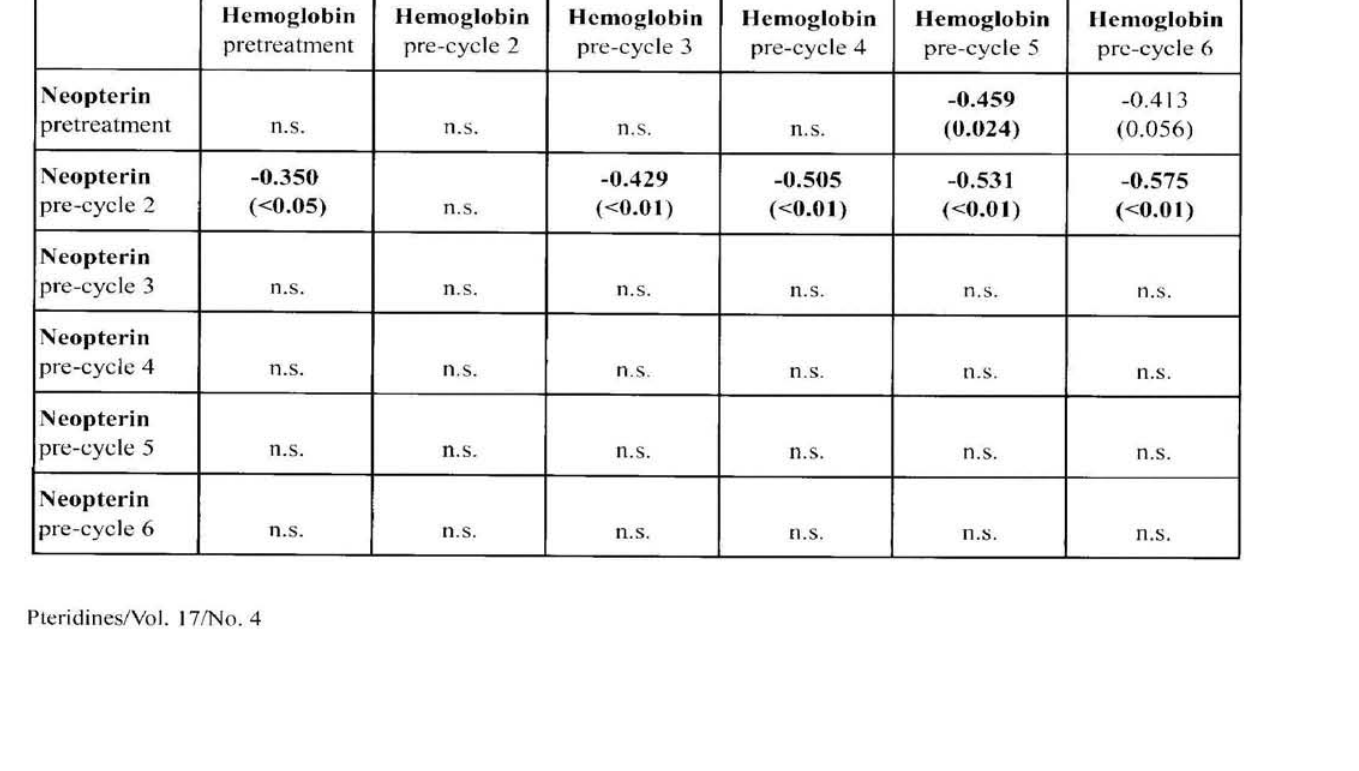
Pteridines/Vol. 17/No.